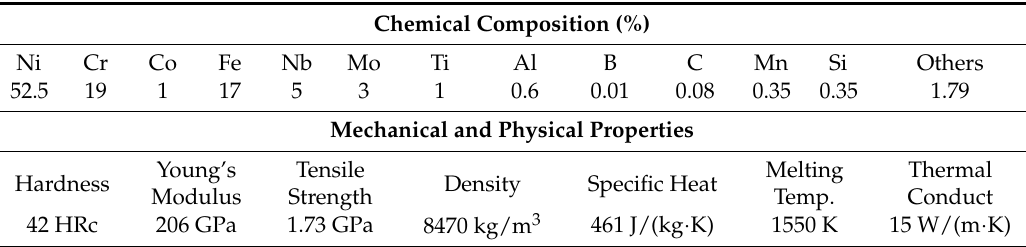
Table 1. Inconel ® 718 chemical composition, mechanical and physical properties [34].